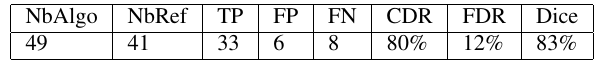
Table 2: Result obtained in our